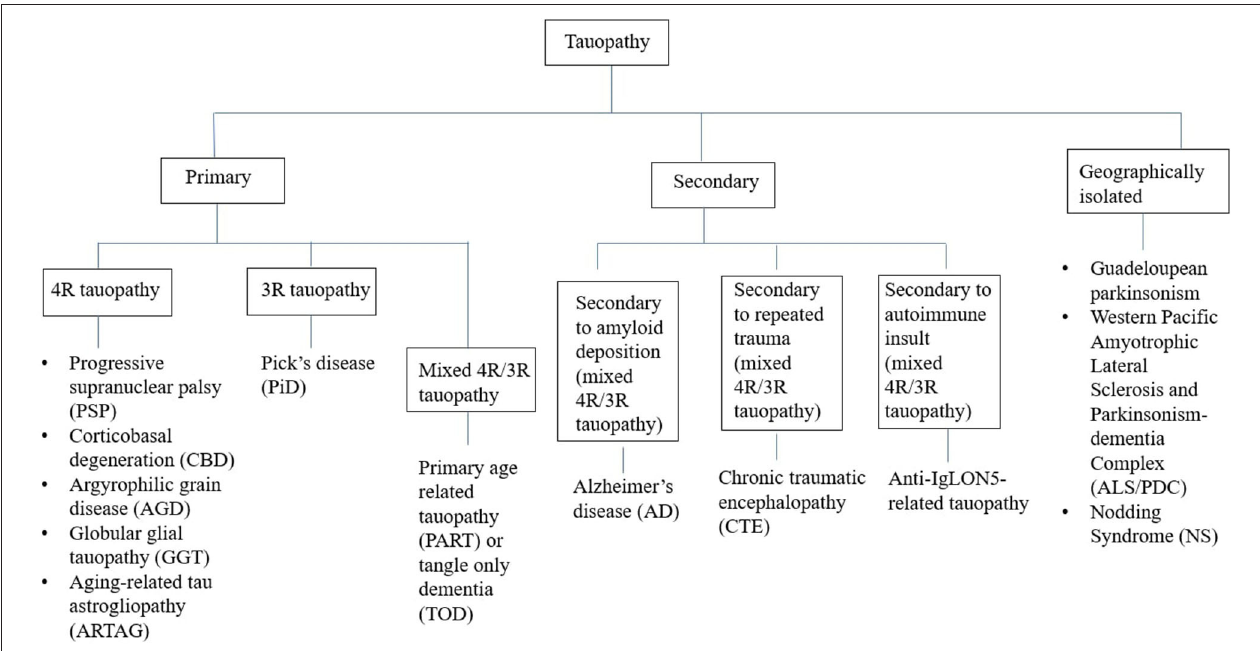
FIGURE 1 | Classification of